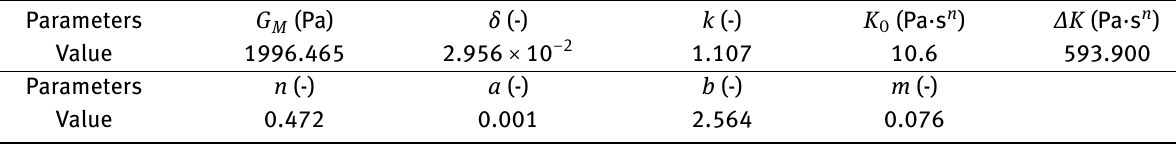
Table 3: The parameter values in Model 2